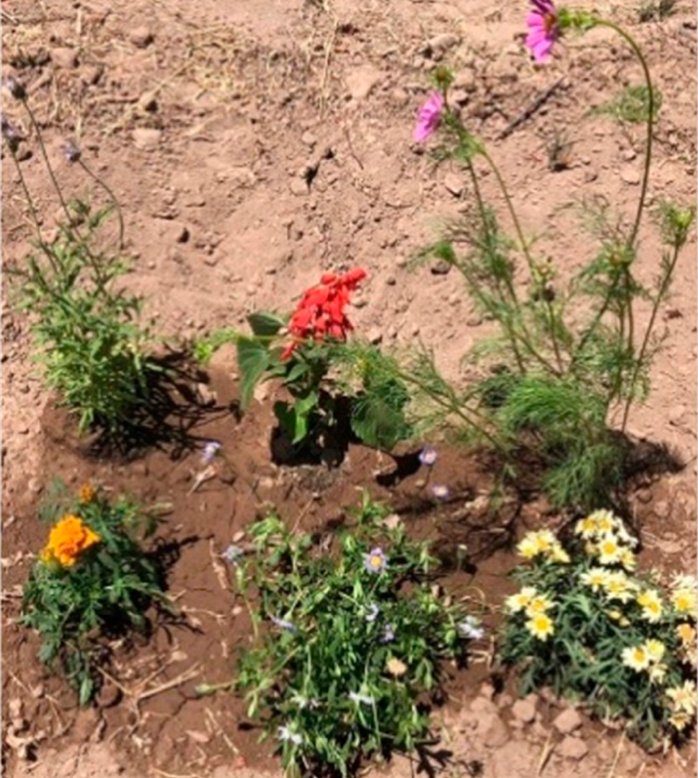
Figure 2. Floral patches installed in the Cucurbita maxima var. Paine crop.